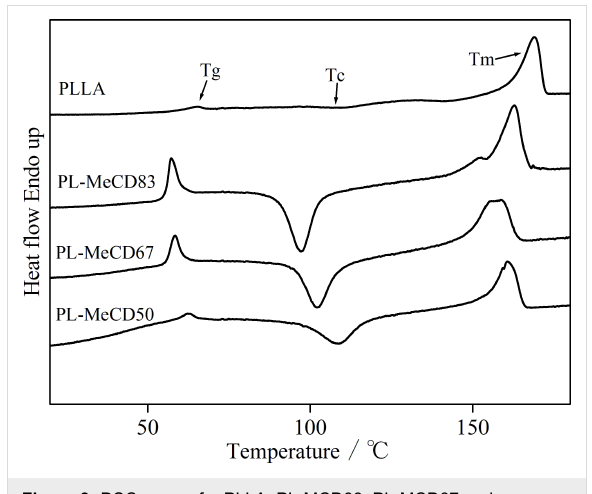
Figure 3: DSC curves for PLLA, PL-MCD83, PL-MCD67 and